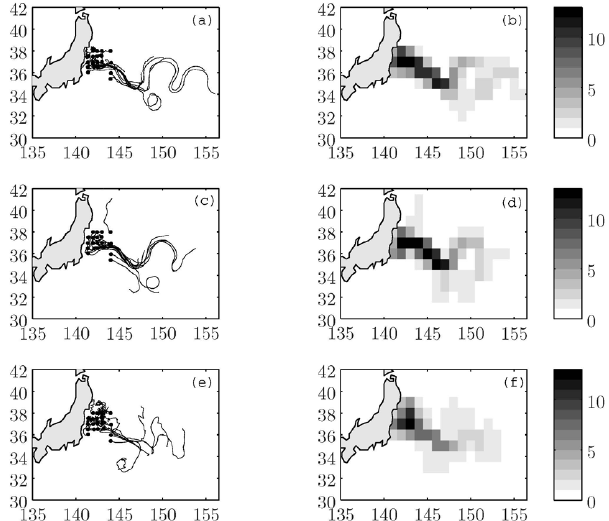
Fig. 4. Comparison between the real and simulated drifter tracks from deployment through 30 June 2011. (a), (c) and (e) on the left show the observed, the observation-based, and the NCOM-based trajectories, respectively. (b), (d) and (f) on the right show the number of drifters visiting each 1x1 bin for the observed, the observation-based and the NCOM-based drifters, respectively.